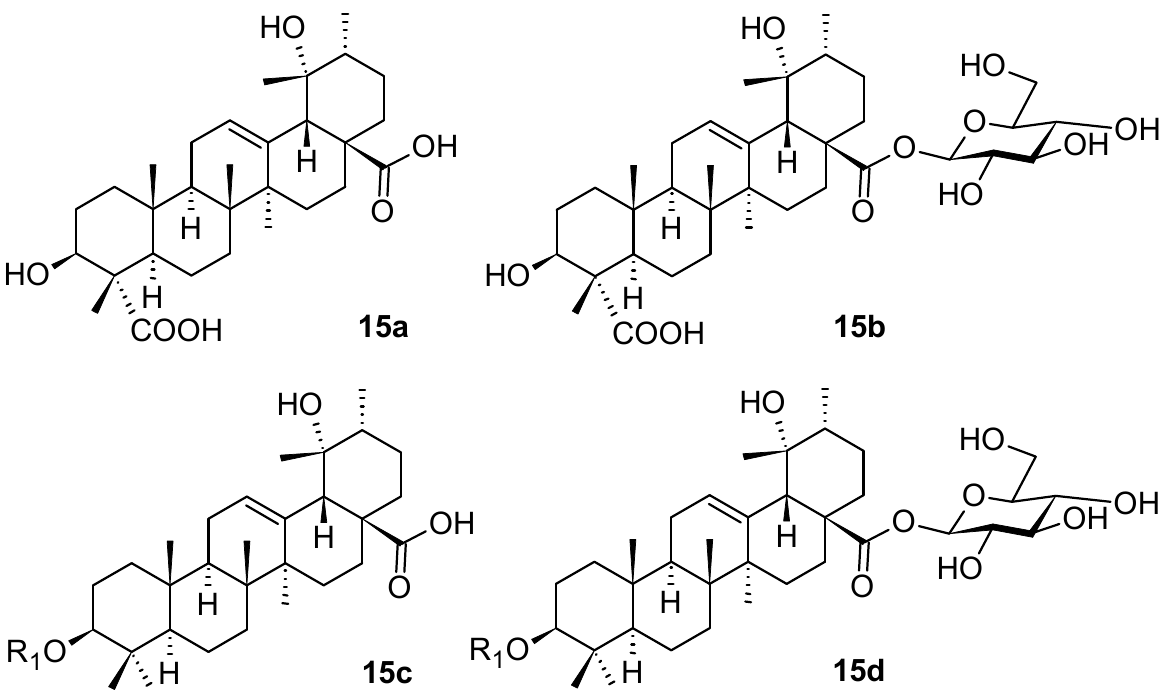
Figure 15. Ursane-type triterpenoid saponins from Ilex pubescens.